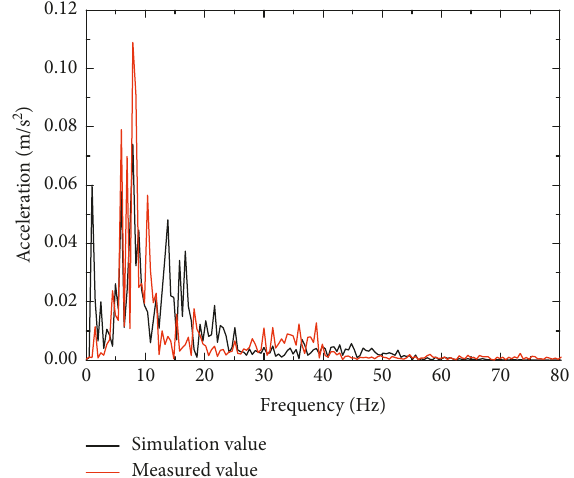
Figure 11: Comparison of measured and simulated acceleration in the frequency